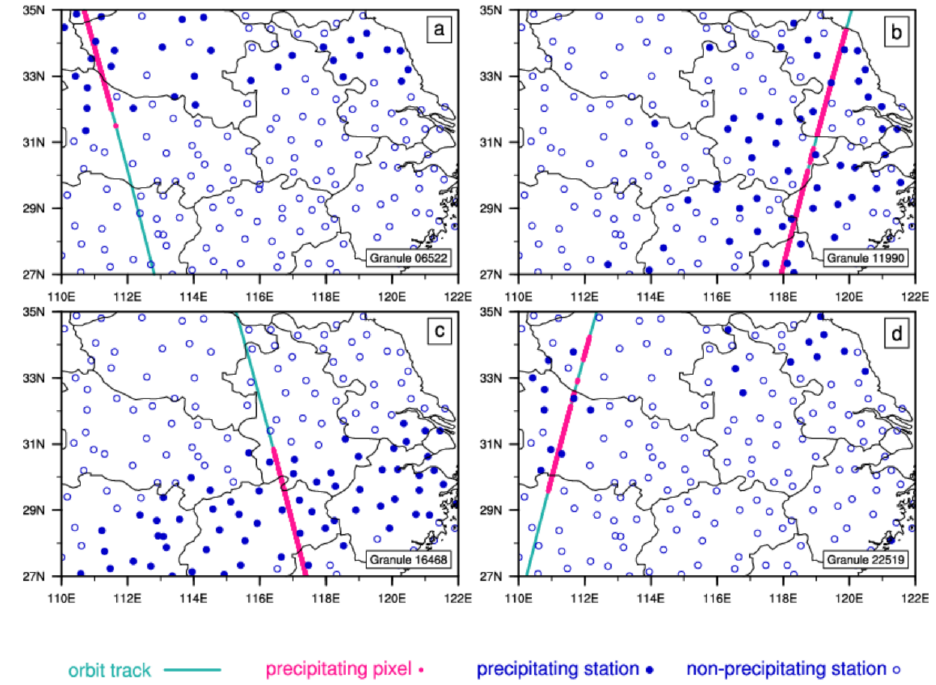
Figure 2. Spatial pattern of CloudSat orbit track for ( a ) granule 06522; ( b ) granule 11990; ( c ) granule 16468; ( d ) granule 22519, and the corresponding precipitation observations of 170 ground-based stations. The dots marked in peach are identified as precipitating pixels by